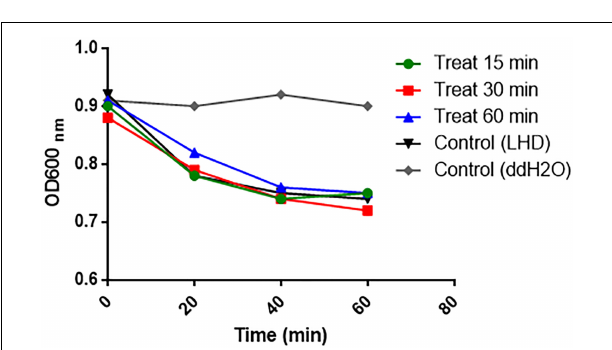
FIGURE 9 | Lytic activity of protein LHD on C. difficile R20291 after treatment in mouse intestinal contents. Protein LHD was incubated with mouse intestinal contents at 37 ◦ C for 15, 30, or 60 min, then optical drop assays were performed on C. difficile R20291 to test the lytic activity of LHD at a concentration of 100 µ g/ml. Experiments were repeated 3 times, and representative data were